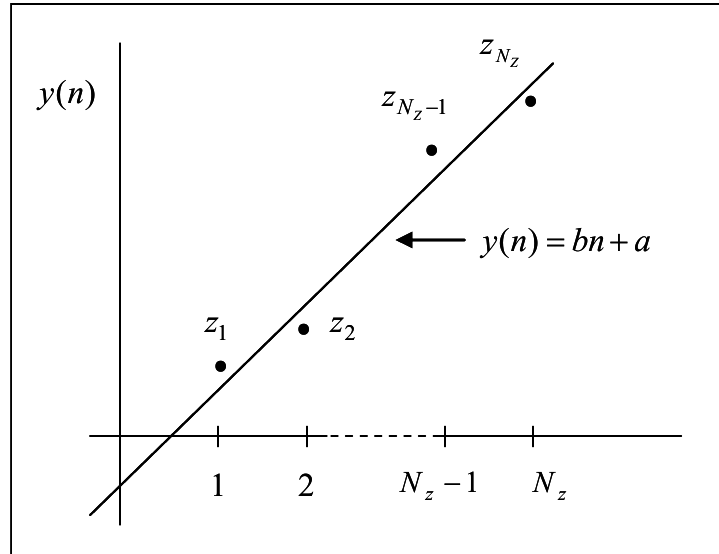
Figure 5 . Least Square Fit of zero crossing